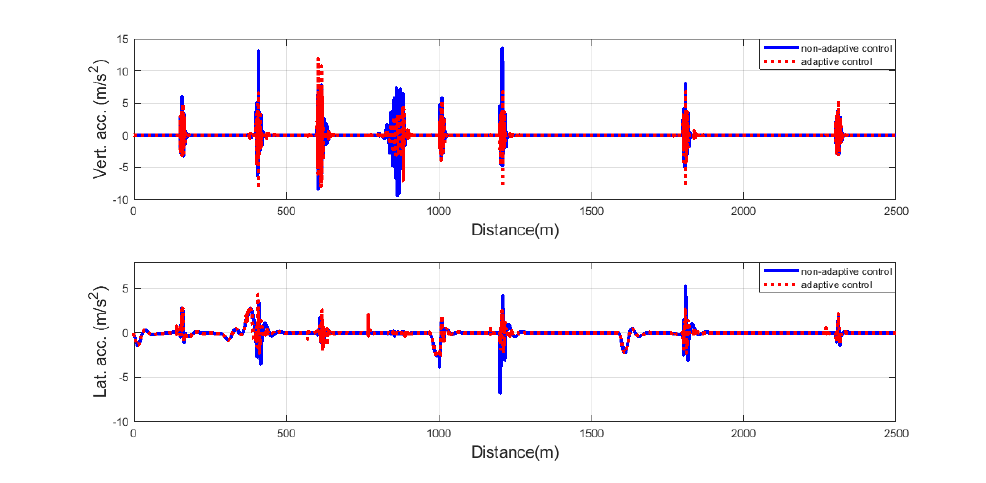
Figure 12. Vertical and lateral accelerations.